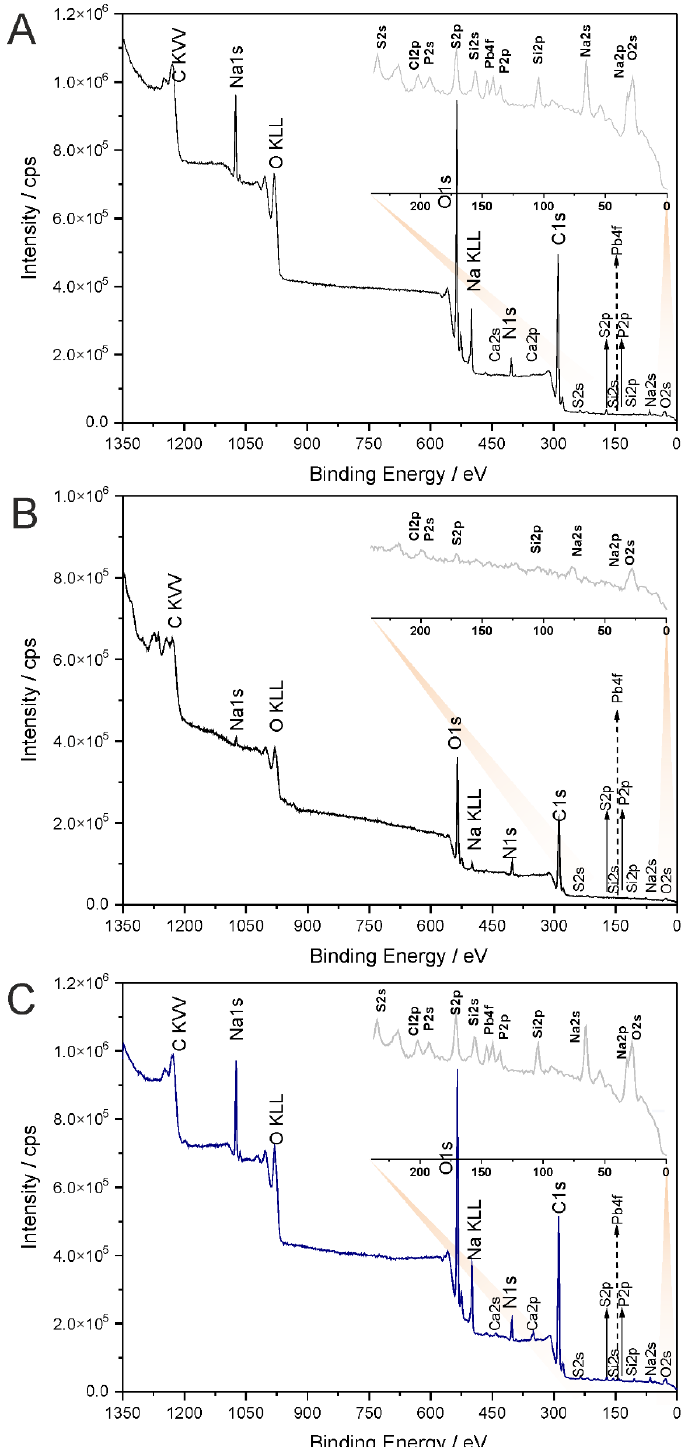
Figure 4. XPS wide scan spectra for ( A ) glucan, ( B ) chitosan and ( C ) hybrid chitosan/1,3- β - D -glucan samples gelled at 90 °C.